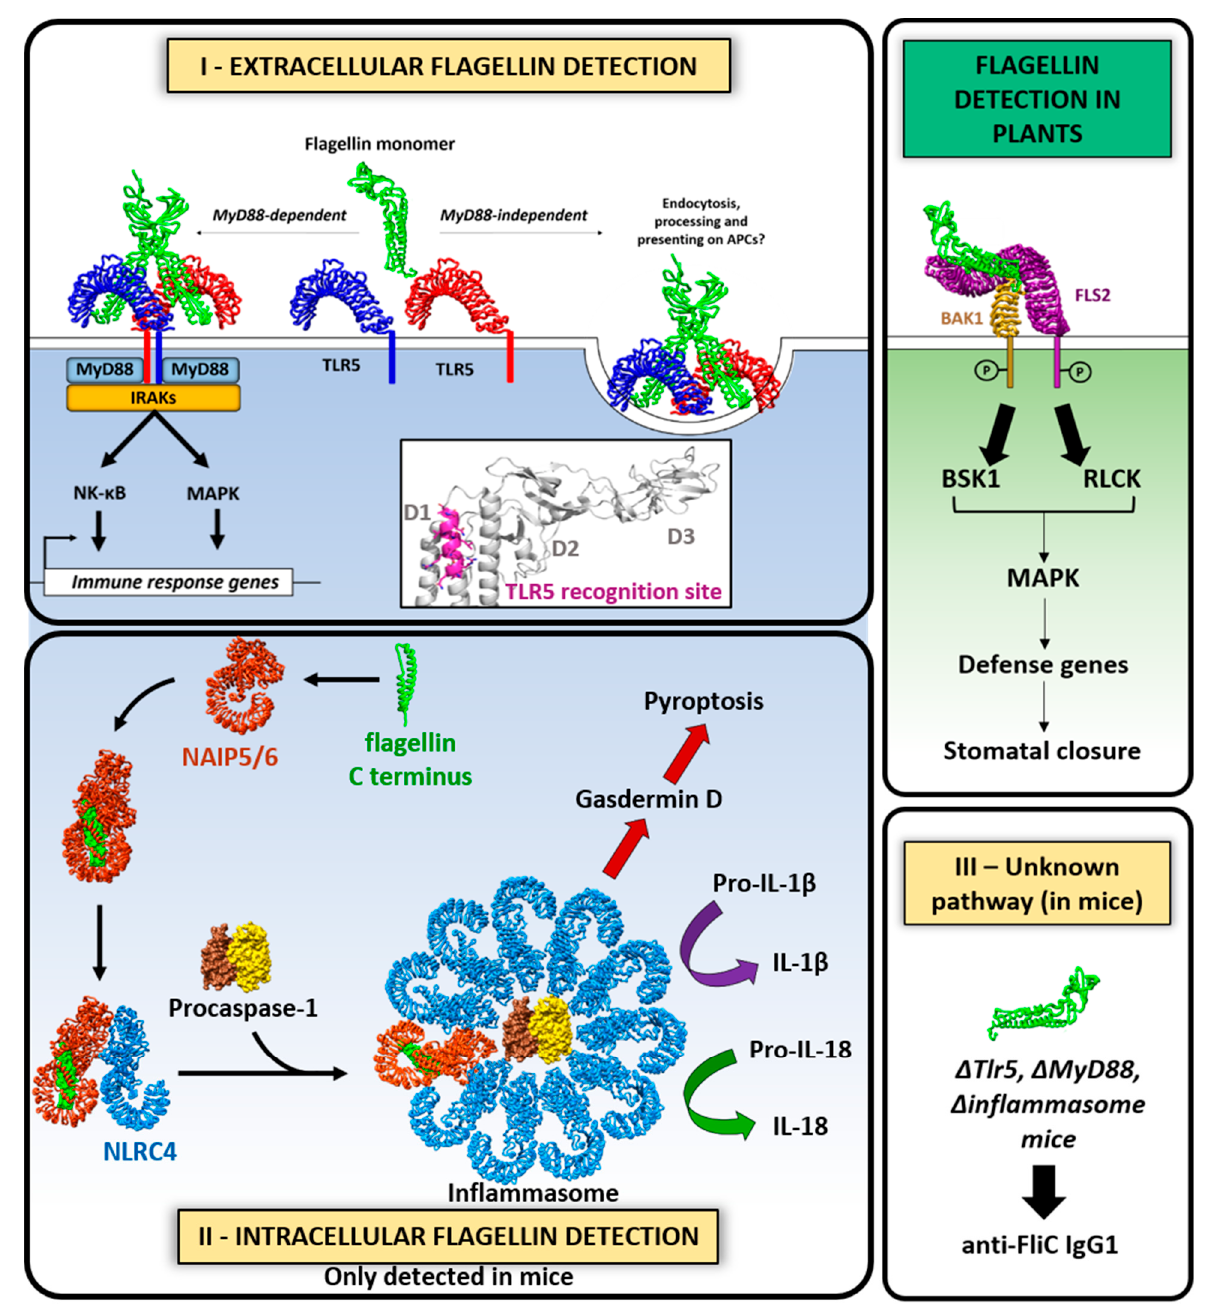
Figure 7. Flagellin recognition by the host. Extracellular detection—TLR5 receptor recognizes region on the D1 domain of flagellin and upon binding, TLR5 dimerizes starting a signaling cascade in the cytoplasm that leads to the alteration of gene expression; Intracellular detection (detected in mice only)—Naip 5 and 6 (NOD-like recpetors) rocognize C terminus of the flagellin. They recrute another NOD-like receptor NLRC4, which oligomerizes and activates caspase 1 forming a structure called inflammasome. Inflammasome activates molecules such as interleukins and gasdermin D leading to pyroptosis; Detection in plants—Plant receptor FLS2 recognizes N-terminal fragment of flagellin and upon binding FLS2 dimerizes with BAK1, protein kinase, starting a downstream signaling cascade that leads to the stomatal closure. TLR5 features 20 tandem copies of leucine-rich repeats (LRRs) in the ectodomain,